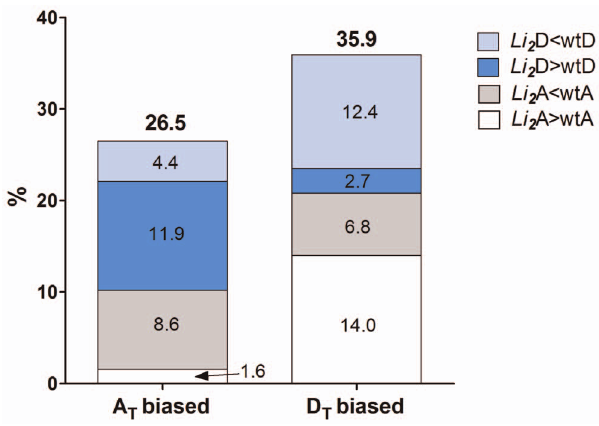
Figure 2. Mutation effects on A T and D T subgenomes of allotetraploid G.hirsutum . The bar chart represents percent of A T and D T biased genes regulated in subgenomes of Li 2 mutant fiber.